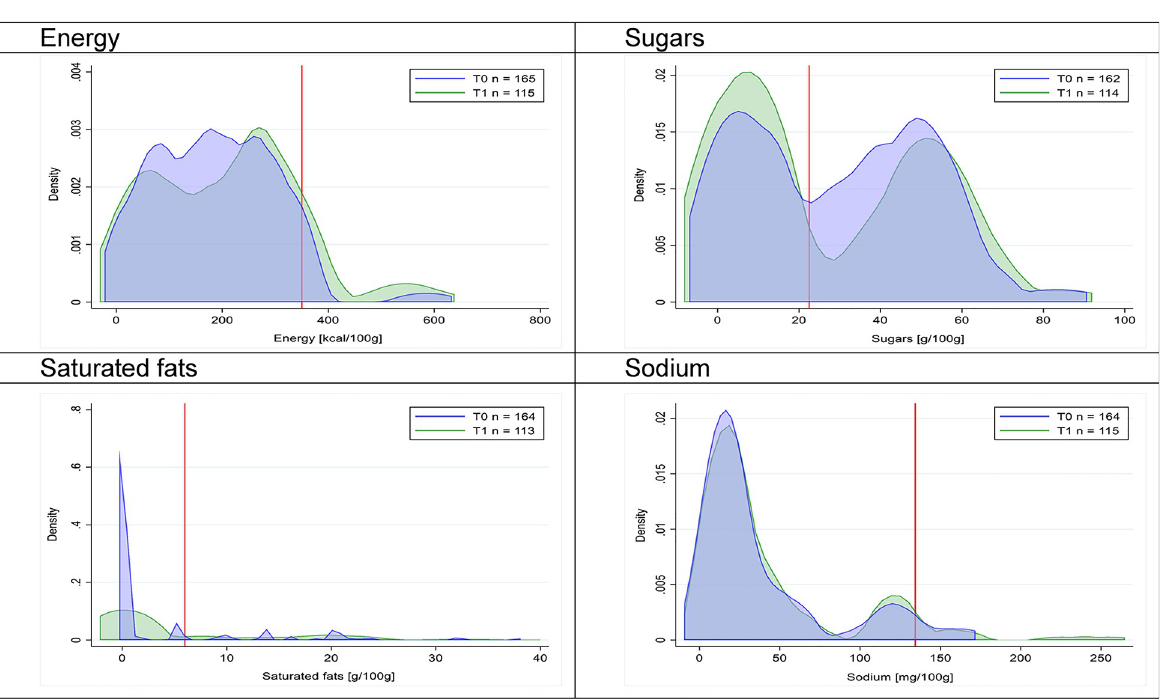
Fig 9. Density curves for the amount of energy and nutrients of concern in sweet spreads, cross-sectional samples. The blue line represents the distribution in T0 (preimplementation), the green line represents the distribution in T1 (postimplementation), and the red line represents the cutoff for the amount of energy or nutrients of concern.